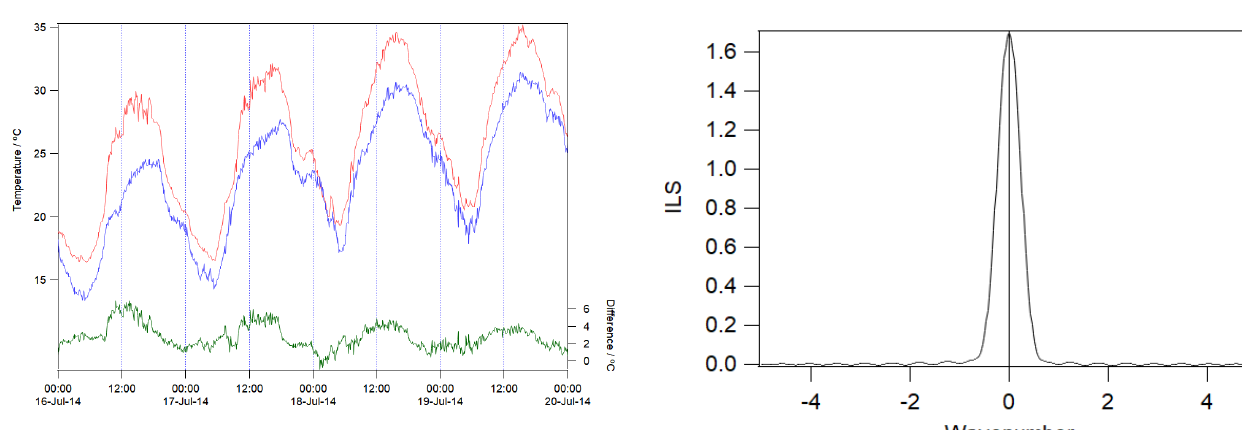
Figure 5. Comparison of IUP meteorological station temperature (red) and spectrum-derived path averaged temperature (blue) for an illustrative period of 4 sunny days. The differences are plotted in green and range from 0 to 6 ◦ C.